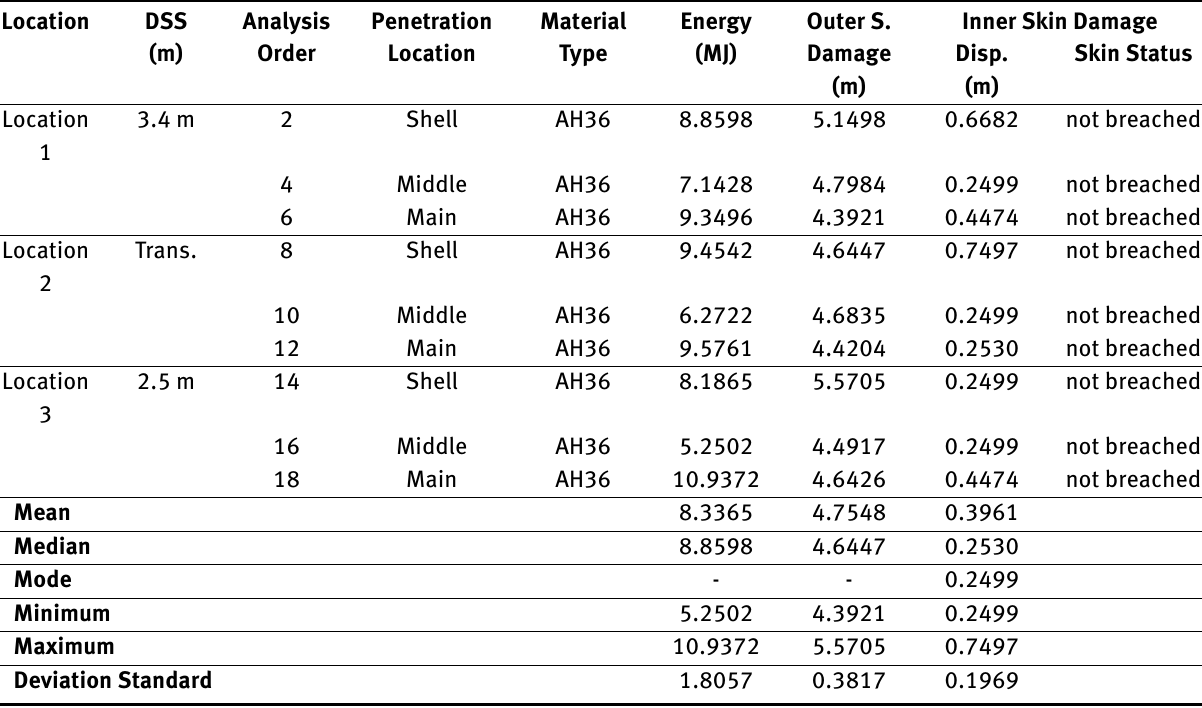
Table B.2: Statistical analysis on repair material